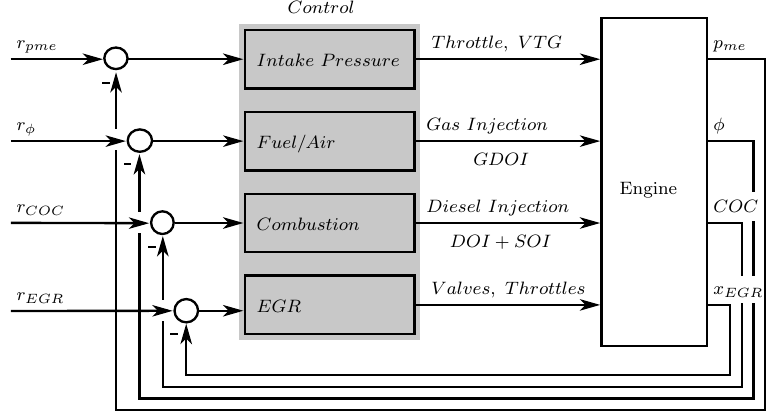
Figure 2. The control structure consists of four feedback loops. The reference variables are brake mean effective pressure p me , fuel-to-air equivalence ratio φ , center-of-combustion COC, and the rate of the exhaust gas recirculation x EGR . The Diesel injection controller was presented in